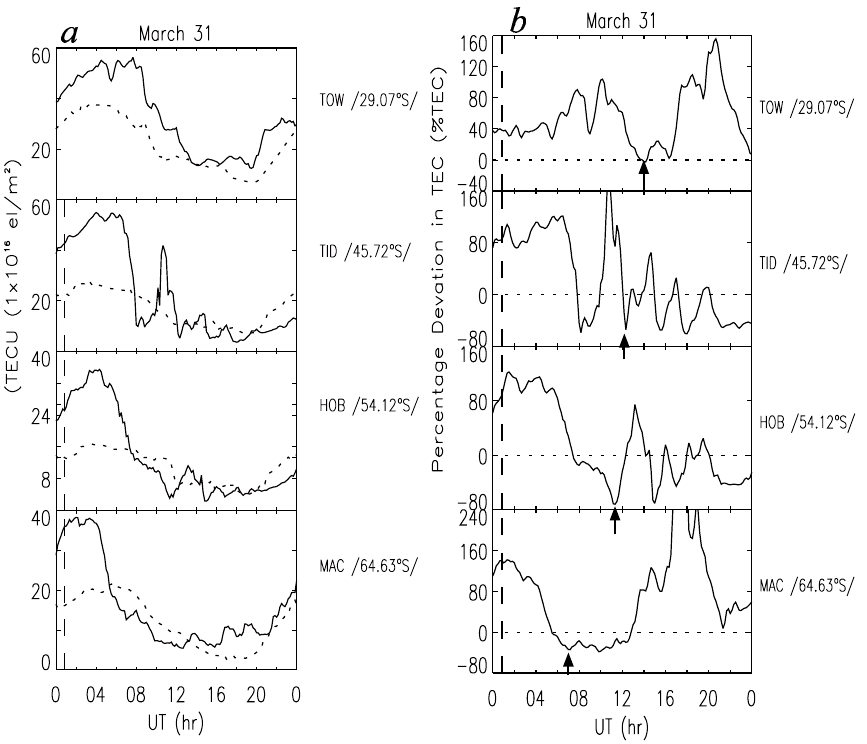
Fig. 4. TEC response for the magnetic storm on 31 March 2001. Temporal profile of GPS TEC (left) and % 1 TEC (right) at different latitudes (all latitudes given are in geomagnetic coordinate system), and the vertical broken line indicates SSC (00:52 UT). The dashed line curves at the left indicate the quiet-time TEC